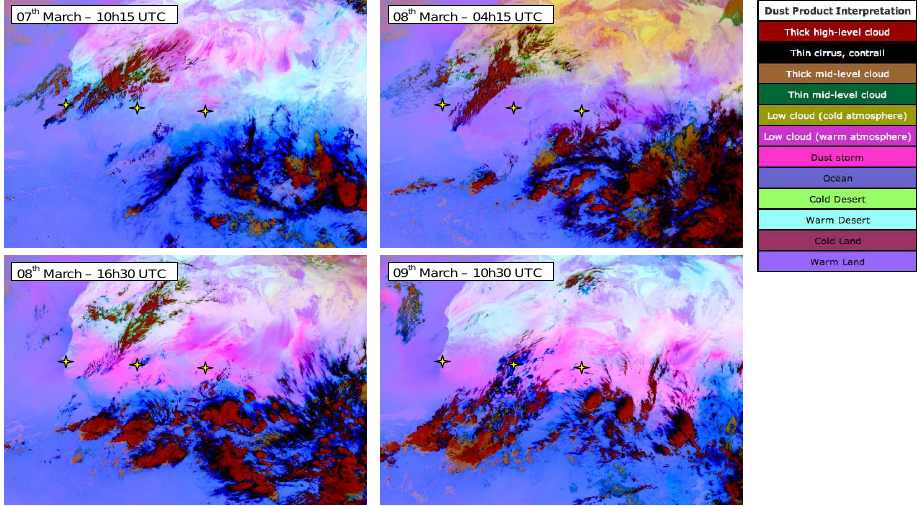
Fig. 11. SEVIRI special dust and pseudo visible products generates using Eumetsat algorithm and data from Eumetsat (infrared channels 12.0, 10.8 and 8.7 mm) of the SEVIRI by the RADAGAST Team (Radiative Atmospheric Divergence using Arm mobile Facility, GERB and AMMA stations: on 7 March 2006 at 10:15, on 8 March 2006 at 04:15 and 16:30 and on 9 March 2006 at 10:30. Dust appears pink or magenta and thick high-level clouds appear in red- brown, showing the presence of convective systems. The yellow stars represent the stations of M’Bour (left), Cinzana (center) and Banizoumbou (right).